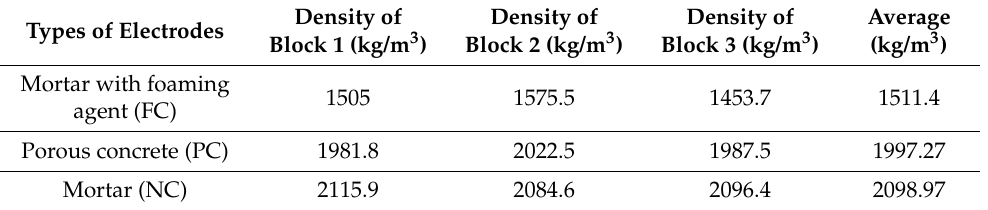
Table 2. Densities of the